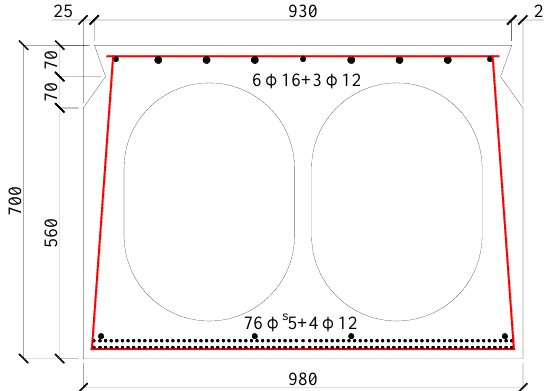
Figure 1. The geometry and size of the hollow-section beam (mm).